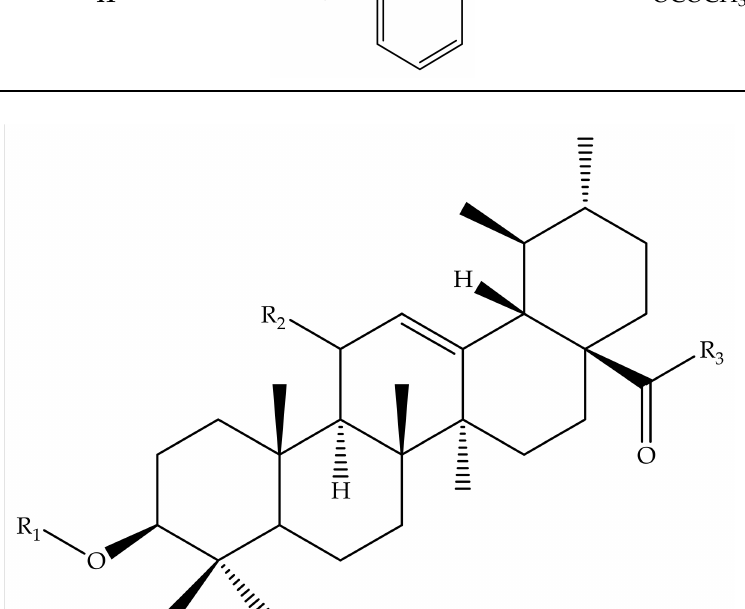
= OCH 2 CH 2 CH 3 ; R 2